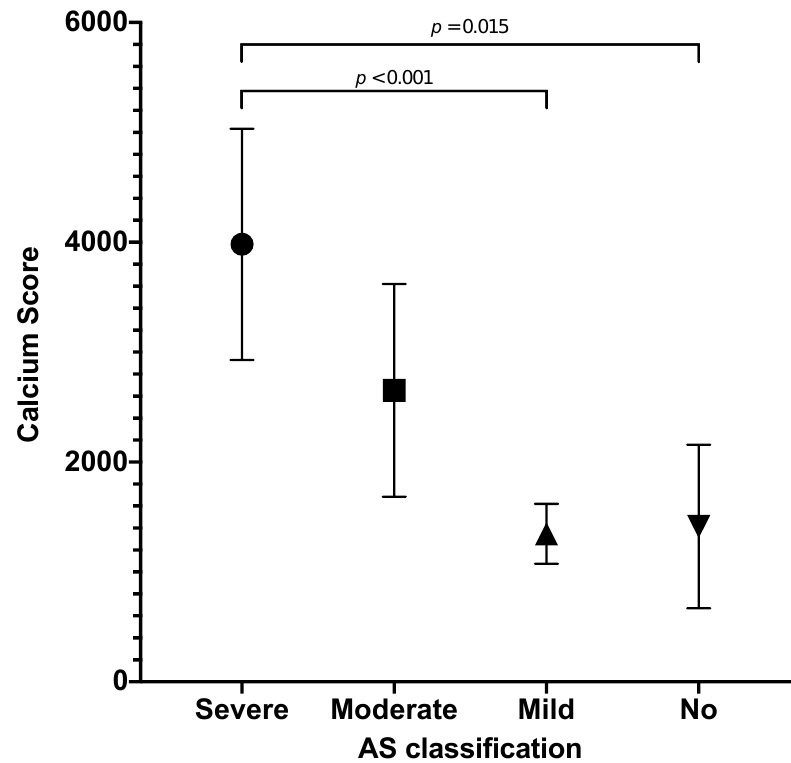
Figure 3. Calcium score stratified by AS category. Mean with 95% confidence intervals. Significant results of ANOVA test denoted.